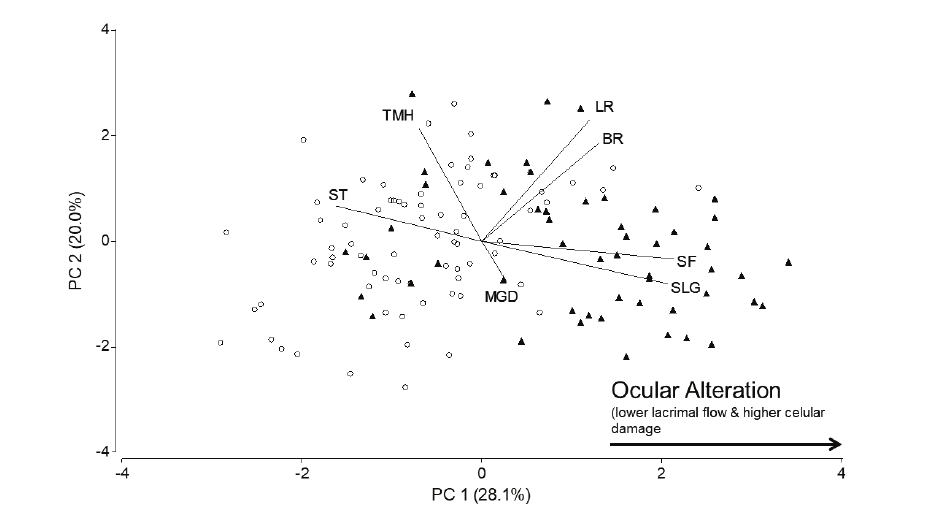
Figure 2. Principal component analysis graph. Each point represents a volunteer: the open circle and black triangle correspond to zones U and I, respectively. The vectors represent the projection of variables: BR, Bulbar redness; LR, Lid redness; SF, Vital staining with fluorescein; SLG, Vital staining with lissamine green; ST, Schirmer I test; and MGD, Meibomian gland dysfunction. Analysis was carried out using the Infostat